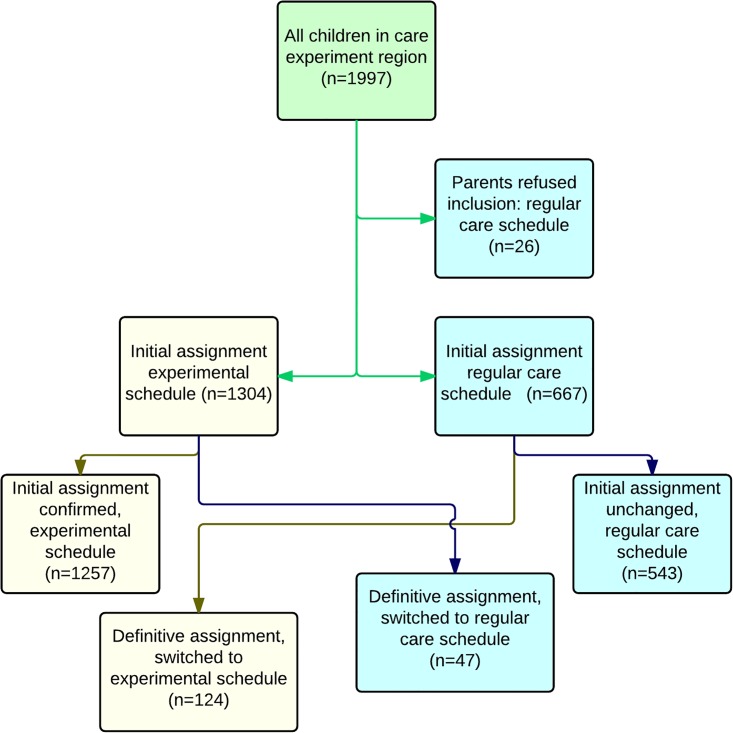
Flow chart assignment procedure, showing number of children assigned to experimental (left) vs regular (right) care schedule.